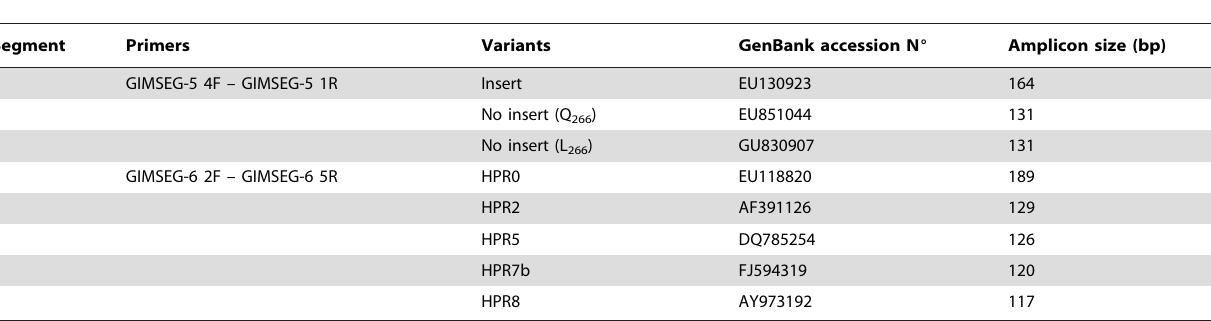
Table 1. Selected components for DGGE